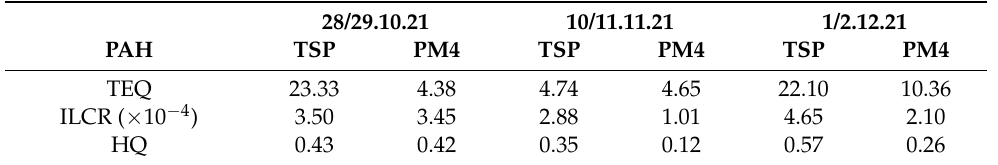
Table 6. The toxicity indices: the toxic equivalent (TEQ, ng/m 3 ), the incremental lifetime cancer risk (ILCR) and the non-cancerogenic hazard quotient index (HQ) calculated based on individual dust fractions and measurement